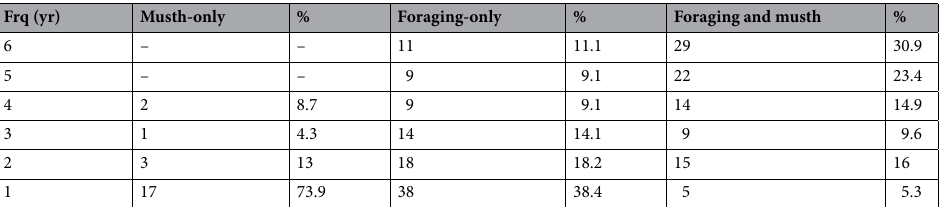
(Table S1). The model including an interaction between age class and state performed best (ANOVA p < 0.0001; Table S1), with results in Table 2. Males following a foraging-only or mixed strategy of PA-use had similar BSIs whereas those following a musth-only strategy were split: the younger age classes showed the lowest BSIs while the oldest age class showed the highest of any category (Fig. 3A). Males employing different strategies did not segregate spatially within the observation area (Fig. 3B).